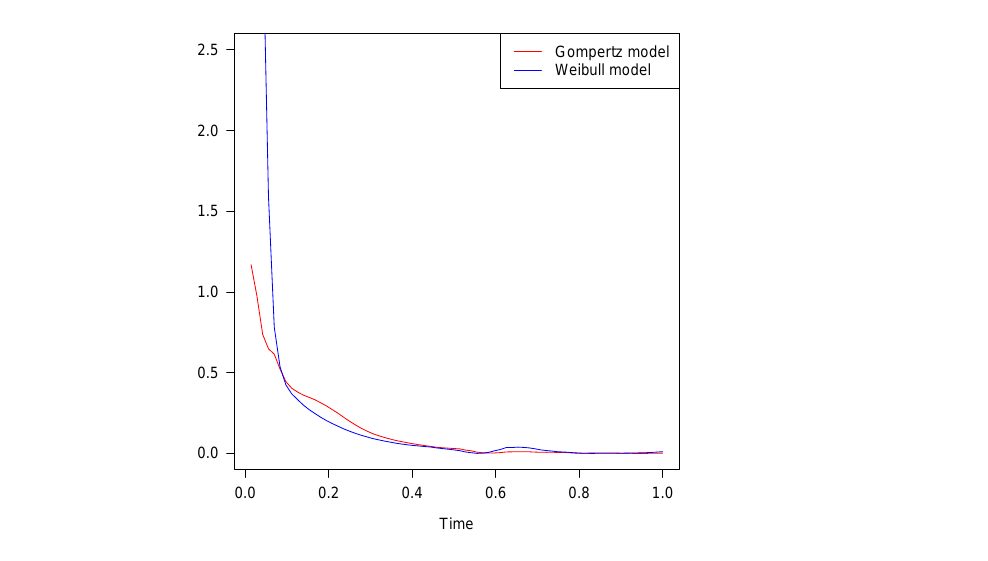
Figure 4. Study of infected: Resistor-average distance between sample and estimated distributions as a function of time for the two estimated models.